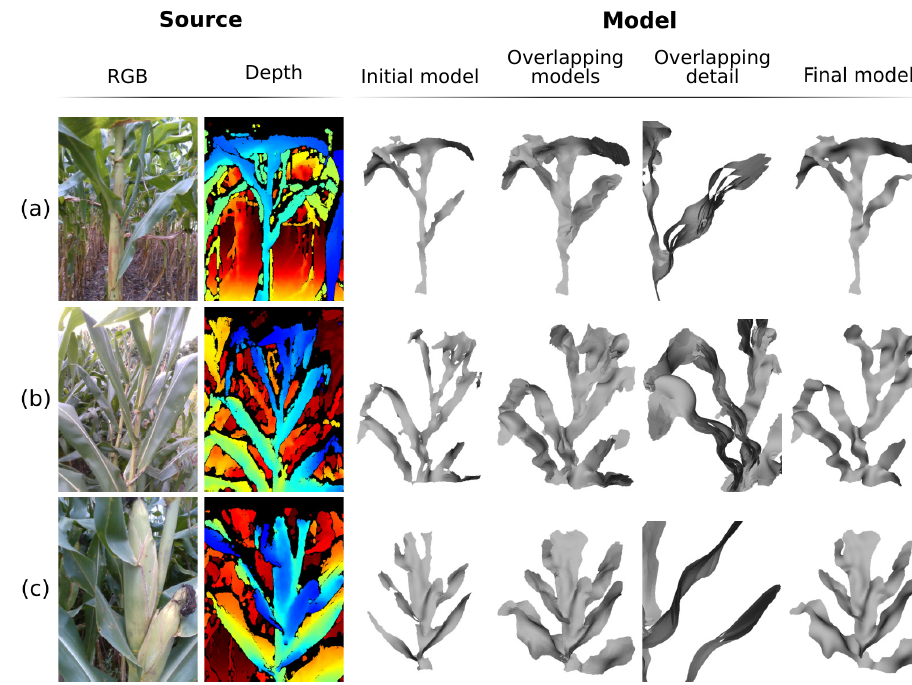
Figure 17. Overlapping of the partial models along the processing for the generation of the plant model. ( a – c ) Examples of non-rigid deformation and data accumulation in the generated